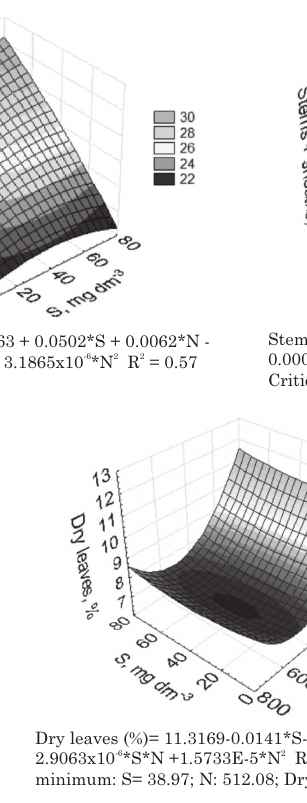
Figure 2. Percentage of aerial segments of Brachiaria decumbens in response to nitrogen and sulfur.